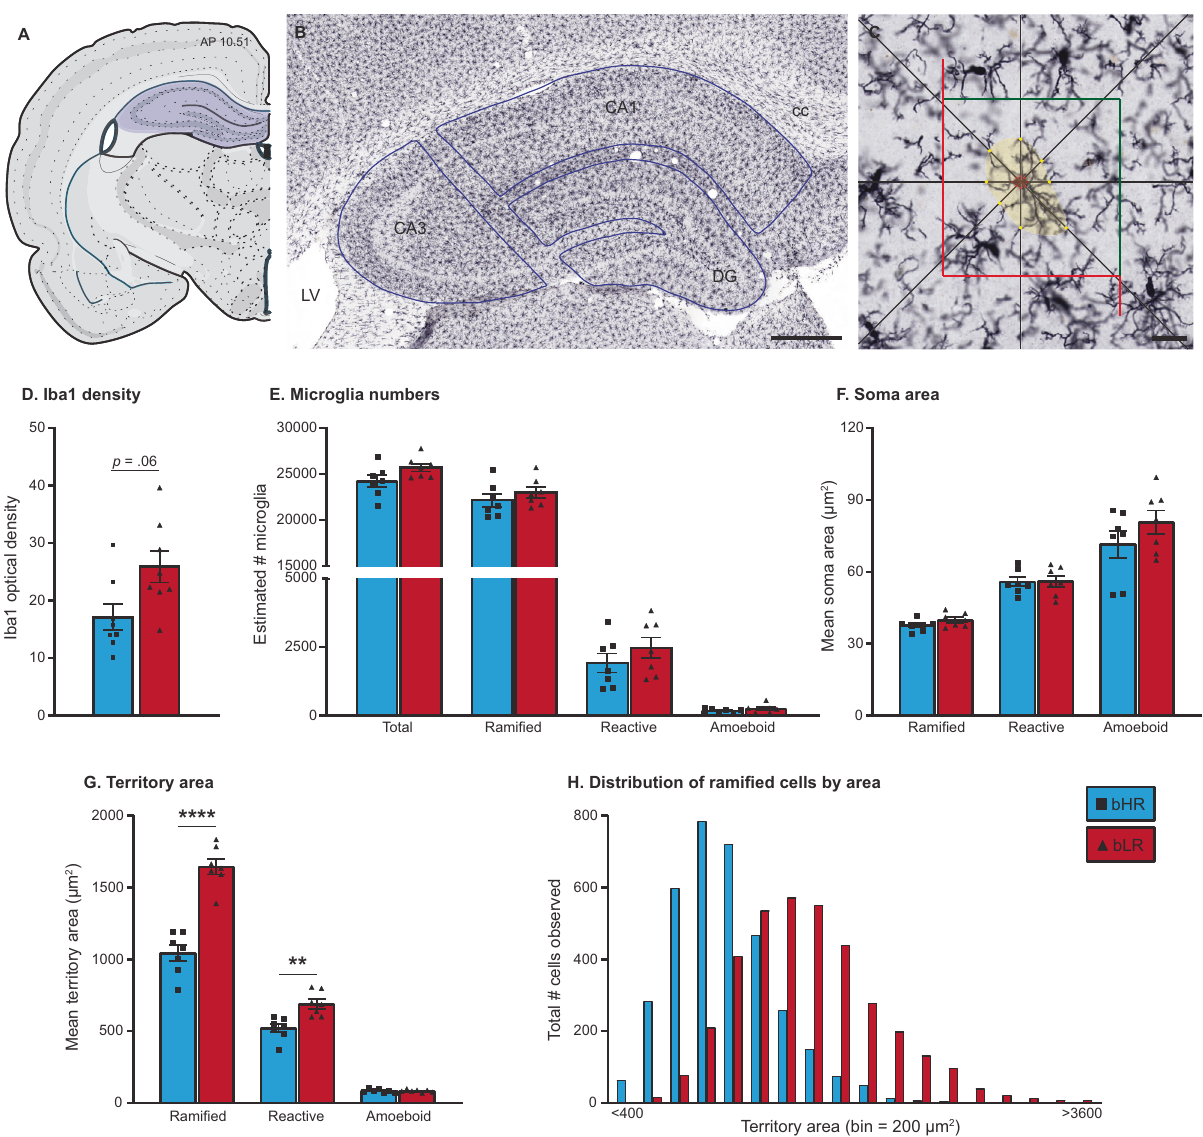
Fig. 4 Comparison of microglia density, numbers, and area in hippocampus of bHRs and bLRs. A Coronal sections of dorsal hippocampus were matched for rostrocaudal level using a Rat Brain Atlas [54] (Atlas levels 28 – 34). B Photomicrograph showing immunohistochemical staining of microglia marker Iba1. The different sub-regions were sampled separately during stereological sampling and were drawn using anatomical landmarks (blue lines). Scale bar = 500 µm. C Recreated depiction of work fl ow using Optical fractionator and Nucleator probes. Cells were counted if soma was within the sampling grid (red and green lines). When a cell was selected, the Nucleator probe applied eight rays from the center of the cell, and points of intersection were used to estimate soma area (red markers) and cell territory (yellow markers, distal extensions of cell processes). Scale bar = 20 µm. D Optical density measurements revealed a trend for higher density of Iba1 staining in hippocampus of bLRs compared to bHRs. E Stereological estimates of total microglia numbers were similar between bHRs and bLRs, regardless of cell type. F , G Soma and territory areas generated using Nucleator Probe were averaged for each subject, according to morphological category ( Rami fi ed, Reactive, Amoeboid ). Although soma area measurements ( F ) were not different between the lines, estimates for territory area ( G ) were larger in bLRs compared to bHRs, speci fi cally in rami fi ed (*** t 12 = 7.709, p < 0.001) and reactive microglia (** t 12 = 3.843, p = 0.002). H A frequency distribution of territory area for all rami fi ed microglia illustrates a normal distribution in both lines, but a notable right-ward shift in territory size of rami fi ed microglia from bLRs compared to bHRs. Data in D – G are expressed as mean ± SEM, with scatter plots overlaid to show individual data points. Abbreviations: CA1 and CA3 = Cornu Ammonis 1 and 3; cc corpus callosum, DG dentate gyrus, LV lateral ventricles. Data are expressed as mean ± SEM, with scatter plots overlaid to show individual data points. of branch points/cell in bLRs (Fig. 5G; all sub-regions p < 0.001). reconstructions generated using Neurolucida (Fig. 5C, D). Overall, As a result, the area of the territory encompassed by the entire the morphological analyses were consistent with the process cell (estimated using convex hull analysis) was larger in bLRs area estimates and provide more detailed information regarding compared bHRs (Fig. 4H), speci fi cally within CA1 ( p < 0.001) and microglia complexity. Although the total number of primary CA3 ( p < 0.001). Soma area from these reconstructions also processes/cell was similar between lines (Fig. 5E; all p > 0.05), revealed a signi fi cantly larger soma area in bLRs within CA1 and these processes were longer in bLRs compared to bHRs (Fig. 5F; CA3 (Table S8). Sholl analyses revealed consistent increases in CA1, p = 0.001; CA3, p < 0.001), and there were higher numbers Translational Psychiatry (2022)